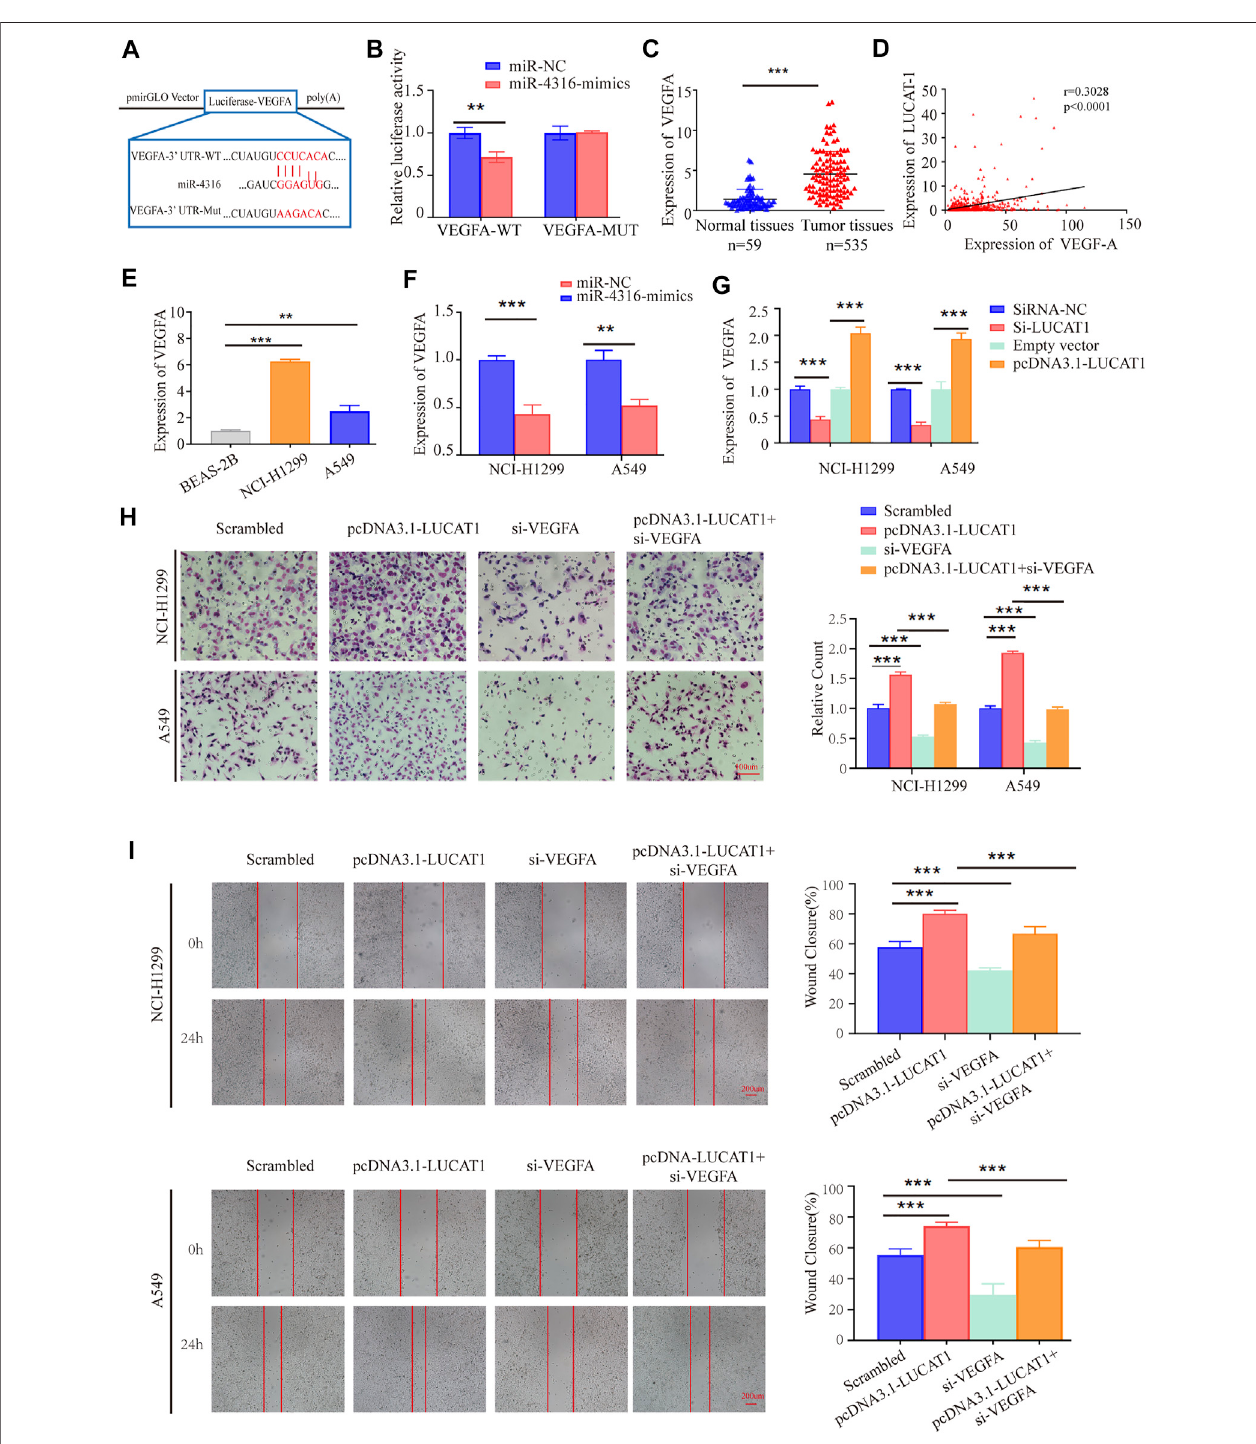
FIGURE 6 | LUCAT1 promotes migration and invasion of LUAD cells via LUCAT1/miR-4316/VEGFA axis. (A) Schematic representation of WT- and Mut-VEGFA sequences. Red fonts represented the mutant bases. (B) The luciferase reporter plasmid containing WT- and Mut-VEGFA was co-transfected into HEK293T cells with miR-4316 or corresponding control. (C) VEGFA expression level in LUAD tissues ( n = 535) and normal tissues ( n = 59) analysed using the TCGA database. (D) Relationship between LUCAT1 and VEGFA was measured using the TCGA database. (E) VEGFA expression was measured in normal lung epithelial cell line (BEAS-2B) and established LUAD cell lines(NCI-H1299 and A549) using qRT-PCR. (F) qRT-PCR was performed todetect the expression ofVEGFA in LUAD cells after transfection of miR-4316 mimics, or control. (G) Relative expression of VEGFA in LUAD cells transfected with si-LUCAT, pcDNA3.1- LUCAT1 or control. (H,I) Migration andinvasionabilityofLUADcellsafterco-transfectionwithnegativecontrolsiRNA,si-VEGFA,or/andoverexpressionplasmid(pcDNA3.1-LUCAT1)weredeterminedby transwell and wound healing assays. p -values were determined by two-tailed student ’ s t-test or one-way ANOVA (* p < 0.05; ** p < 0.01; *** p < 0.001).